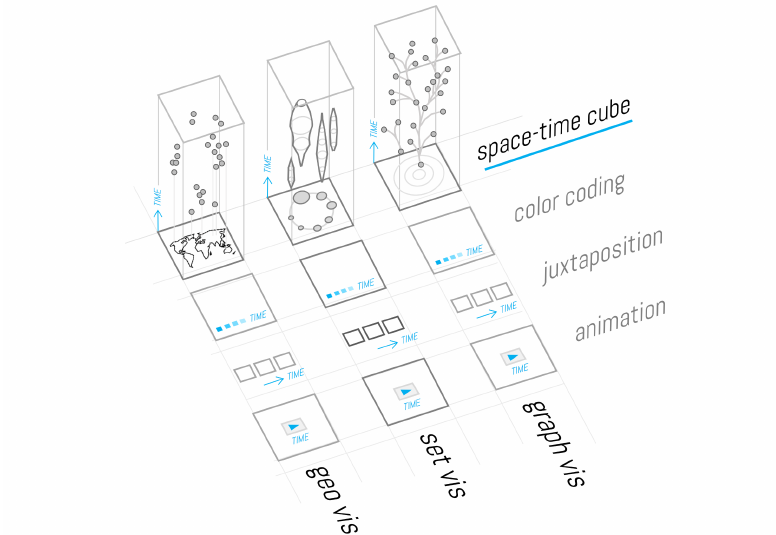
Figure 5. The functional architecture of the PolyCube framework includes a geographic, a set-typed, and a relational perspective—in all of whose time-orientation (blue) can be visually analyzed fourfold: with space-time cubes, color coding, juxtaposition views, or